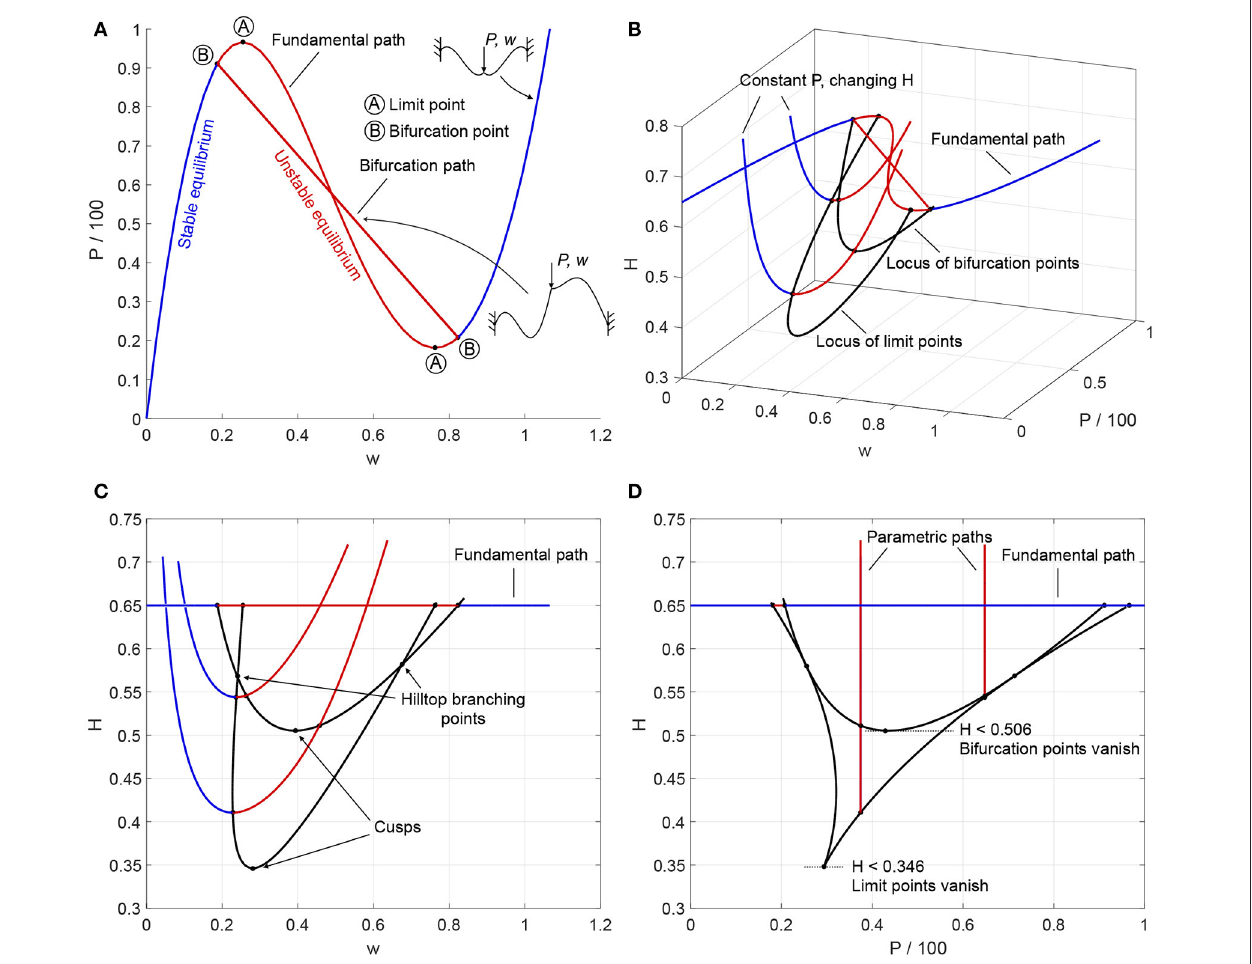
FIGURE 6 | (A) Fundamental and bifurcation equilibrium paths of load ( P ) vs. central displacement ( w ) for a toggle frame of height H fundamental and bifurcation paths in displacement-load-height space, two additional parametric paths showing the relationship between height ( H ) and central displacement ( w ) at applied loads of P 37.4 and P 64.8, and locus of limit and bifurcation points with changing height; (C,D) Orthographic projections of (B) in = = displacement-height and load-height space, respectively, indicating cusp catastrophes and hilltop-branching